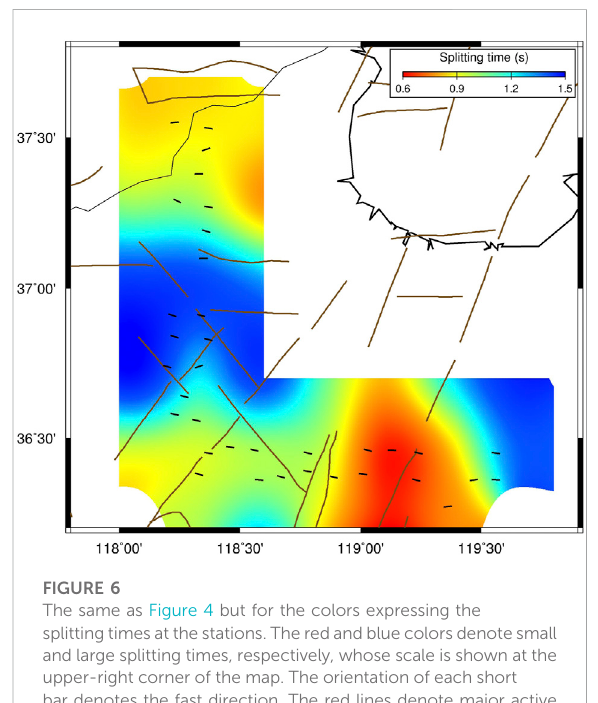
FIGURE 6 The same as Figure 4 but for the colors expressing the splittingtimesatthestations.Theredandbluecolorsdenotesmall and large splitting times, respectively, whose scale is shown at the upper-right corner of the map. The orientation of each short bar denotes the fast direction. The red lines denote major active faults (Deng et al.,